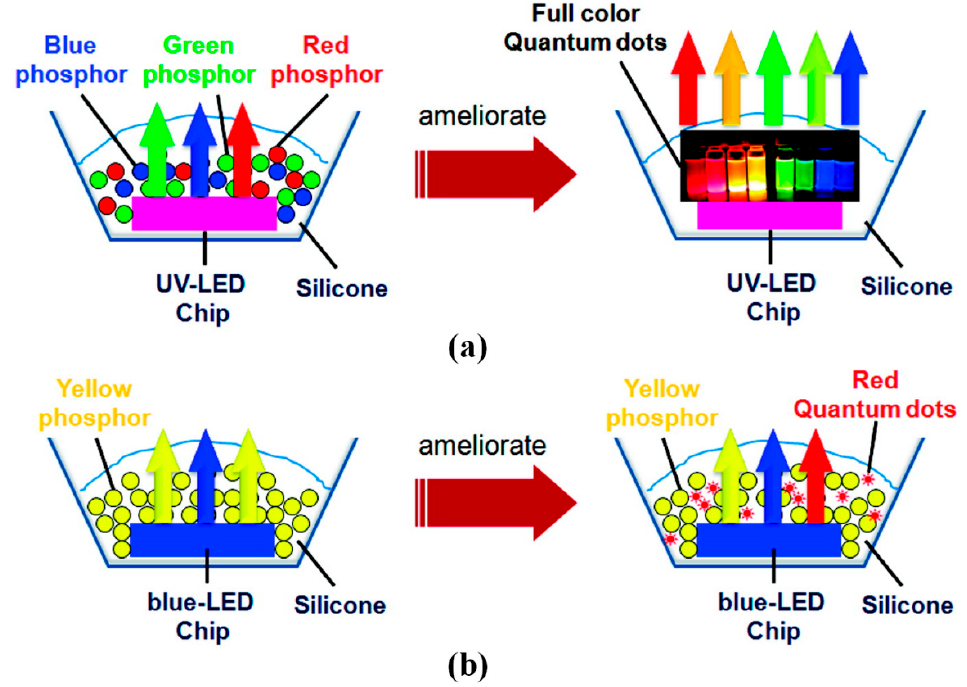
Figure 2. Structures for generating white light from fluorescent materials, based on ( a ) UV chip and ( b ) blue chip. Reprinted with permission from [29] . Copyright 2011, American Chemical Society. ( b ) blue chip. Reprinted with permission from [29]. Copyright 2011, American Chemical